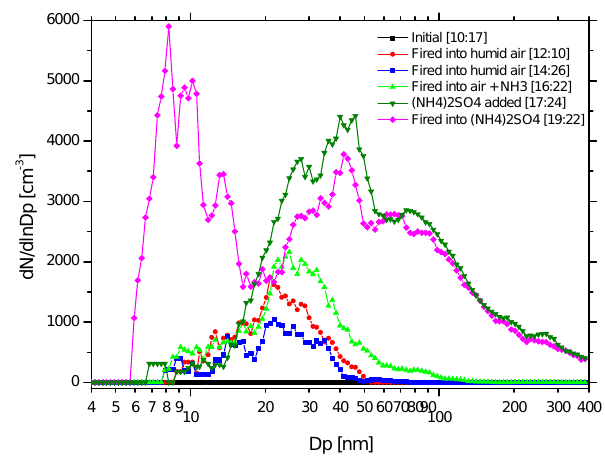
Fig. 5. Particle size distributions for selected times during experi- ments 4, 6, and 7 in synthetic air at 283K and about 60% relative humidity. Times in the legend refer to Fig.